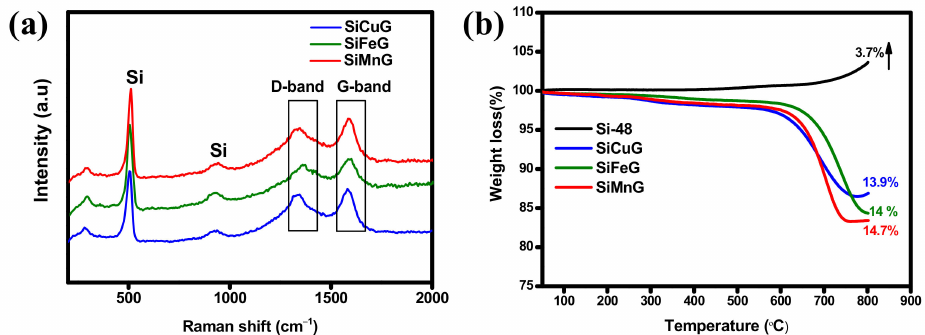
Figure 3. ( a ) Raman spectra of SiCuG, SiFeG, and SiMnG. ( b ) TGA results of Si-48, SiCuG, SiFeG, and